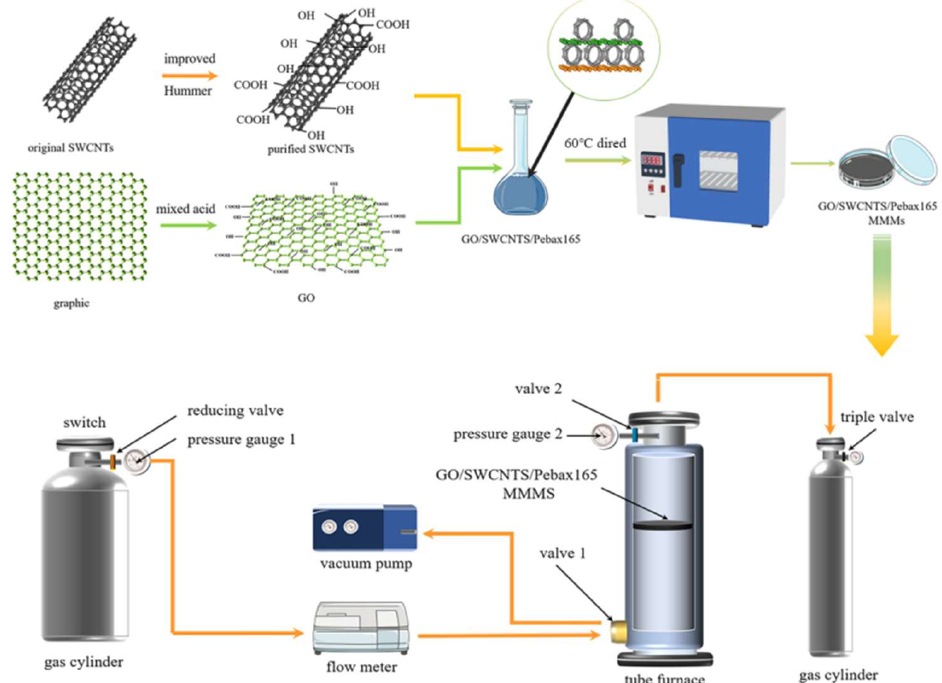
Figure 1. The preparation of MMMs and the performance of gas separation.